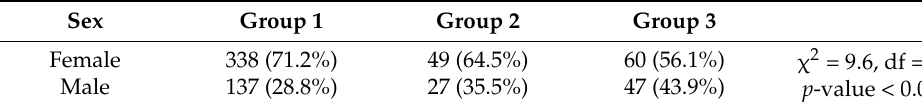
Table 1. Sex distribution in the studied samples.